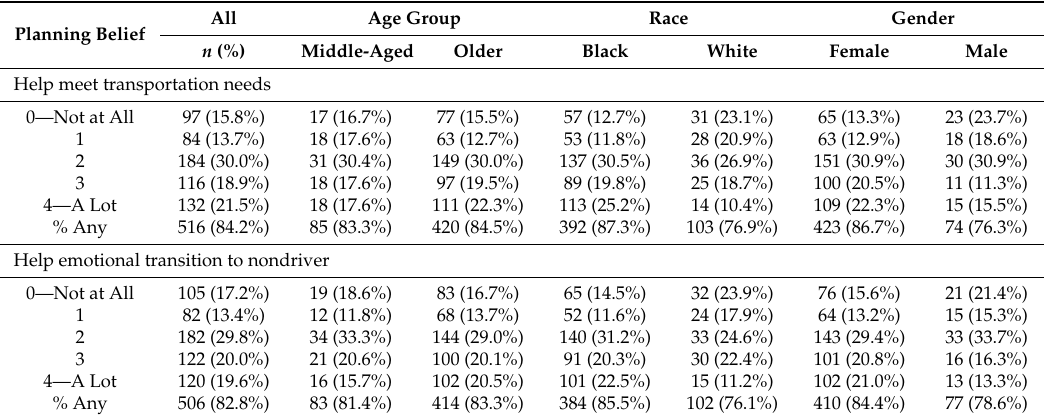
Table 5. Drivers’ Beliefs about Effects of Planning for Future Transportation